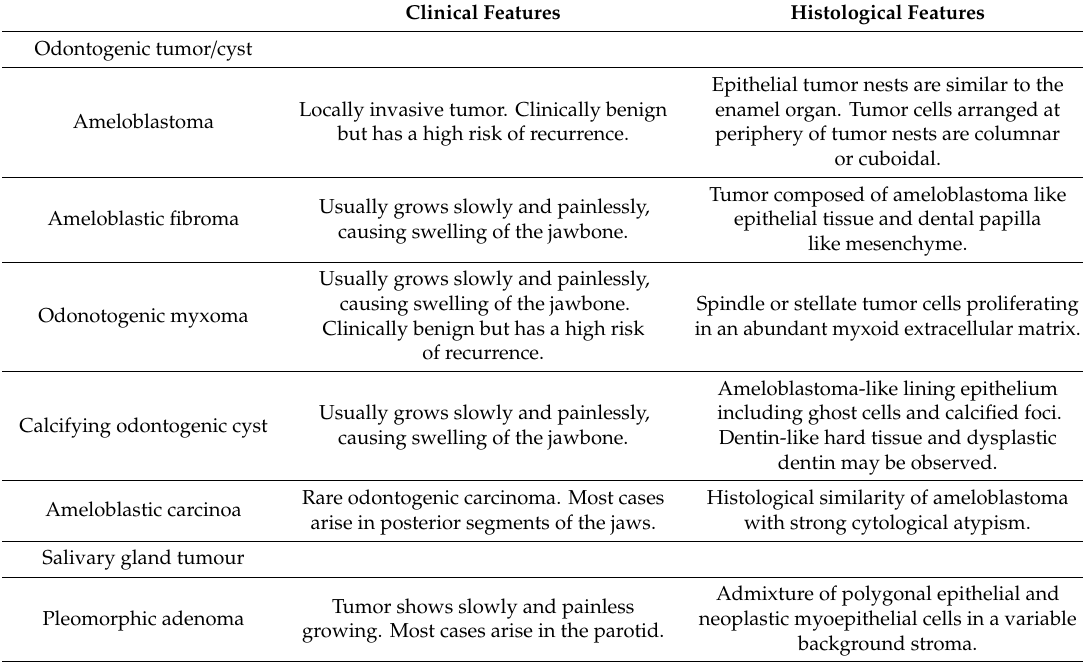
Table 1. Clinical and histological features in di ff erent type of oral